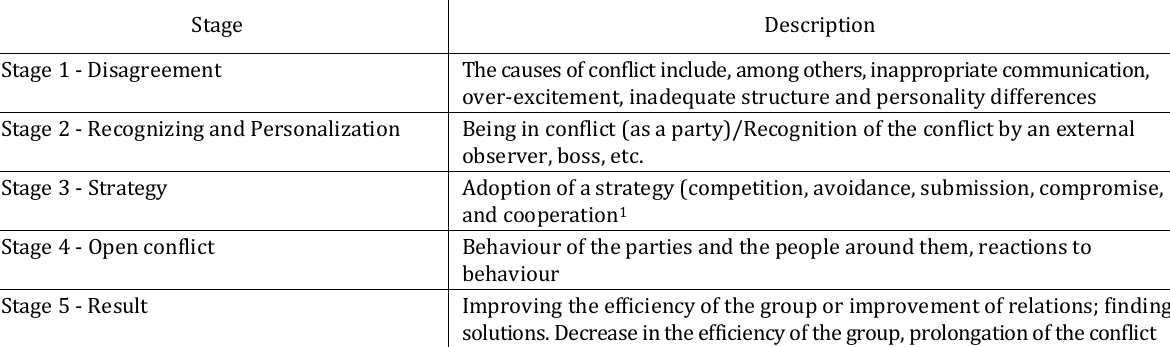
Table 1. The conflict process (Idziak,